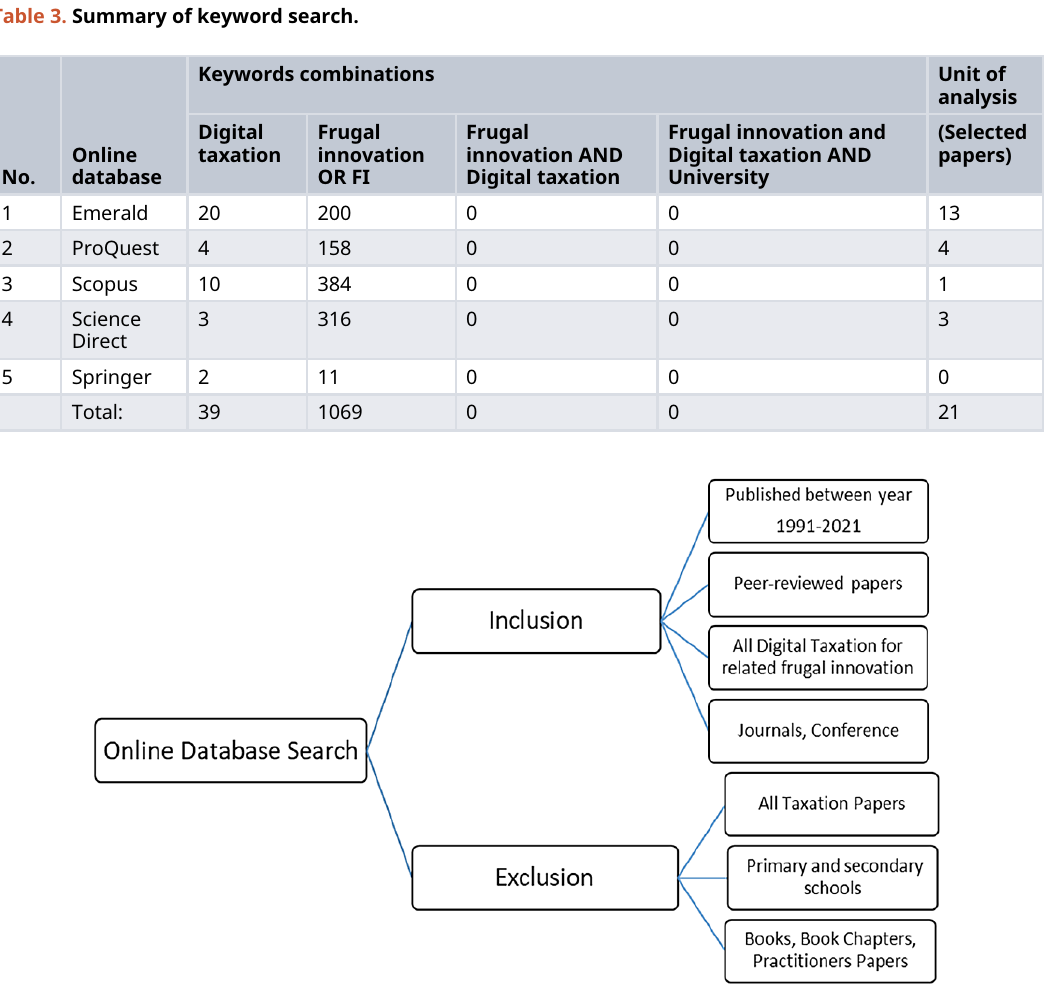
Table 3. Summary of keyword search.